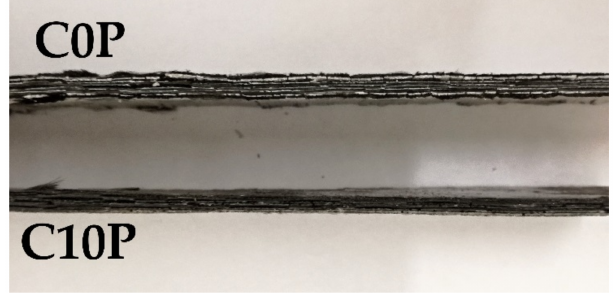
Figure 5. Difference in the thickness of samples C0P and C10P after 800 ◦